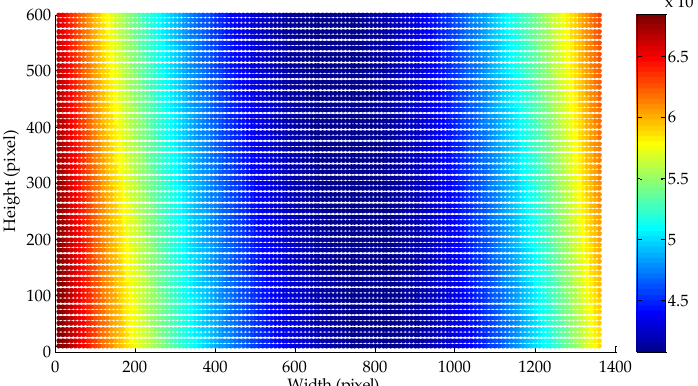
Figure 4. RMS versus the pixel coordinates of the feature point.